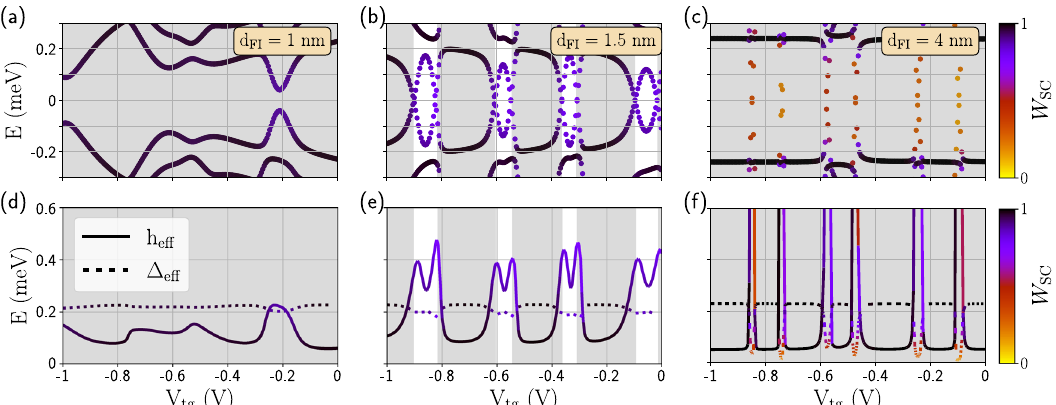
Fig. 2 Topological phase diagrams for different FI thicknesses. Top row: energy spectrum at k x = 0 as a function of the top-gate voltage V tg for a FI thickness of ( a ) d FI = 1 nm, ( b ) d FI = 1.5 nm and ( c ) d FI = 4 nm. Colors represent the weight W SC of each state in the superconducting Al layer. Shaded V tg regions are those characterized by a trivial phase, i.e., Q ¼ þ 1 ; while white regions correspond to a topological phase, i.e., Q ¼ (cid:2) 1 . Bottom row ( d , e , f ): effective exchange coupling h eff (solid lines) and superconducting pairing amplitude Δ eff (dotted lines) for the lowest-energy state in ( a ), ( b ), ( c ), respectively, as given by Eqs. 2 and Fig. 2 we show the energy spectrum of the system at k x = 0 as a function of the top-gate voltage for three different values of the FI thickness ( d FI ). The white (gray) background denotes the topological (trivial) phase, determined by the corresponding topological invariant. Left panels in Fig. 2 show the regime where the FI is too thin to induce a topological phase transition. The energy spectrum shows low-energy bands localized mainly in the SC, represented by the black color in Fig. 2a. In this case, superconductivity dominates the properties of the low-energy modes. In Fig. 2d we show the effective superconducting pairing amplitude (dotted line) and exchange coupling (solid line) calculated using Eqs. 2 and 3. For this thickness, we observe that h eff is mostly below Δ eff , consistent with the system being in the trivial regime as the topological